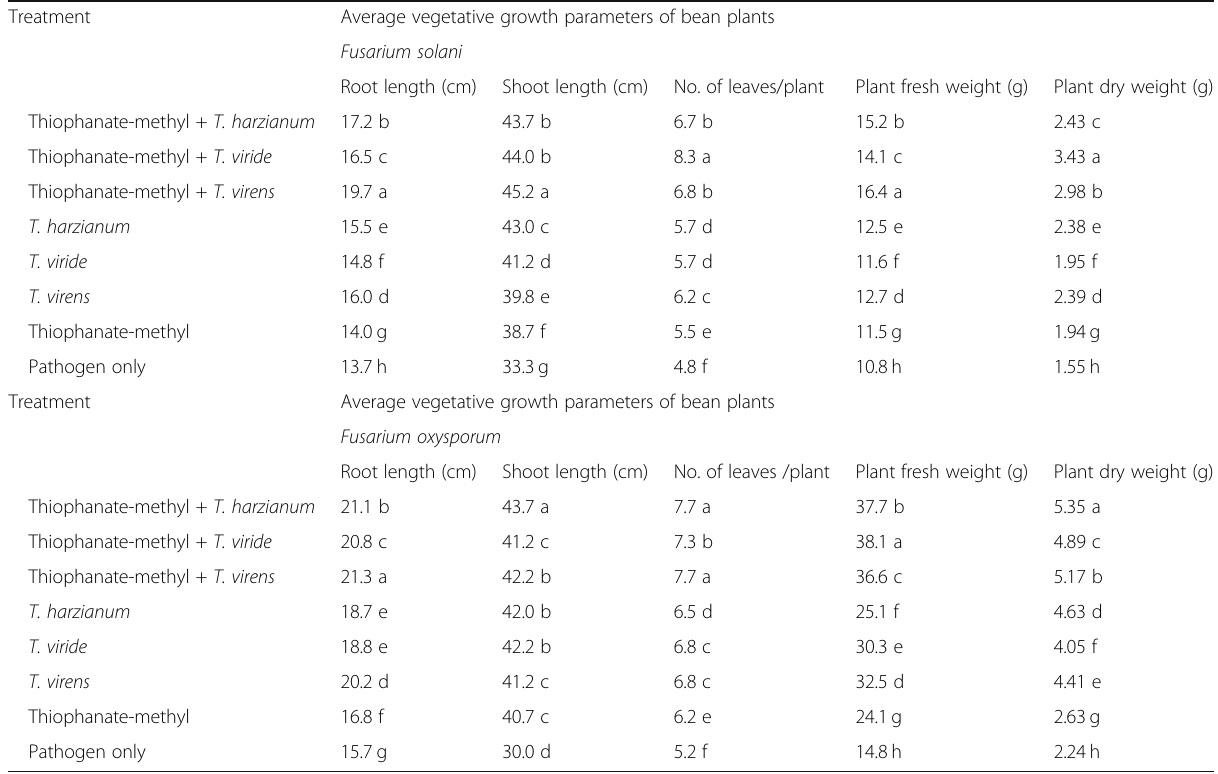
Table 2 Effect of soil application with Trichoderma spp. and seed coating with thiophanate-methyl employed either alone or in combination on vegetative growth parameter of dry bean plants grown in soil artificially infested with each of Fusarium solani and Fusarium oxysporum under greenhouse conditions